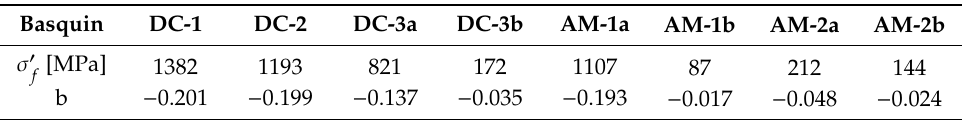
Figure 7. S-N (Woehler) curves from HCF to VHCF regime for ( a ) die-cast (DC) alloy AlSi7Mg0.3 and ( b ) additively manufactured (AM) alloy AlSi12. ( b ) additively manufactured (AM) alloy AlSi12. Table 4. S-N curve parameters of die-cast (DC) and additively manufactured (AM) alloy AlSi7Mg0.3 and AlSi12 related to